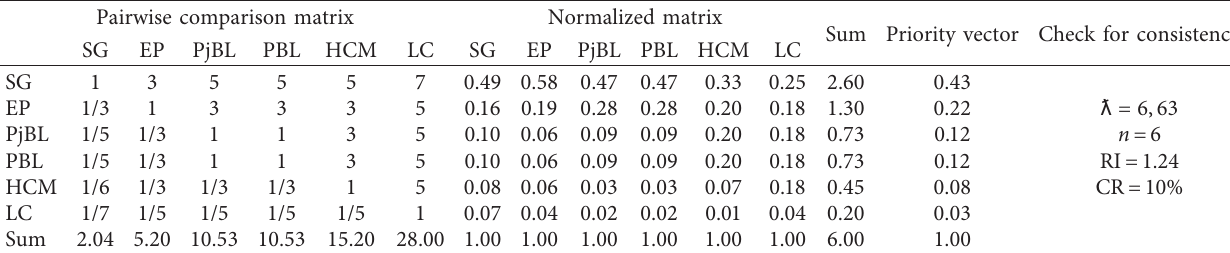
Table 11: Pairwise comparison matrix of learning strategies with respect to the Criterion “SS3. Using technology in engineering practice.” Pairwise comparison matrix